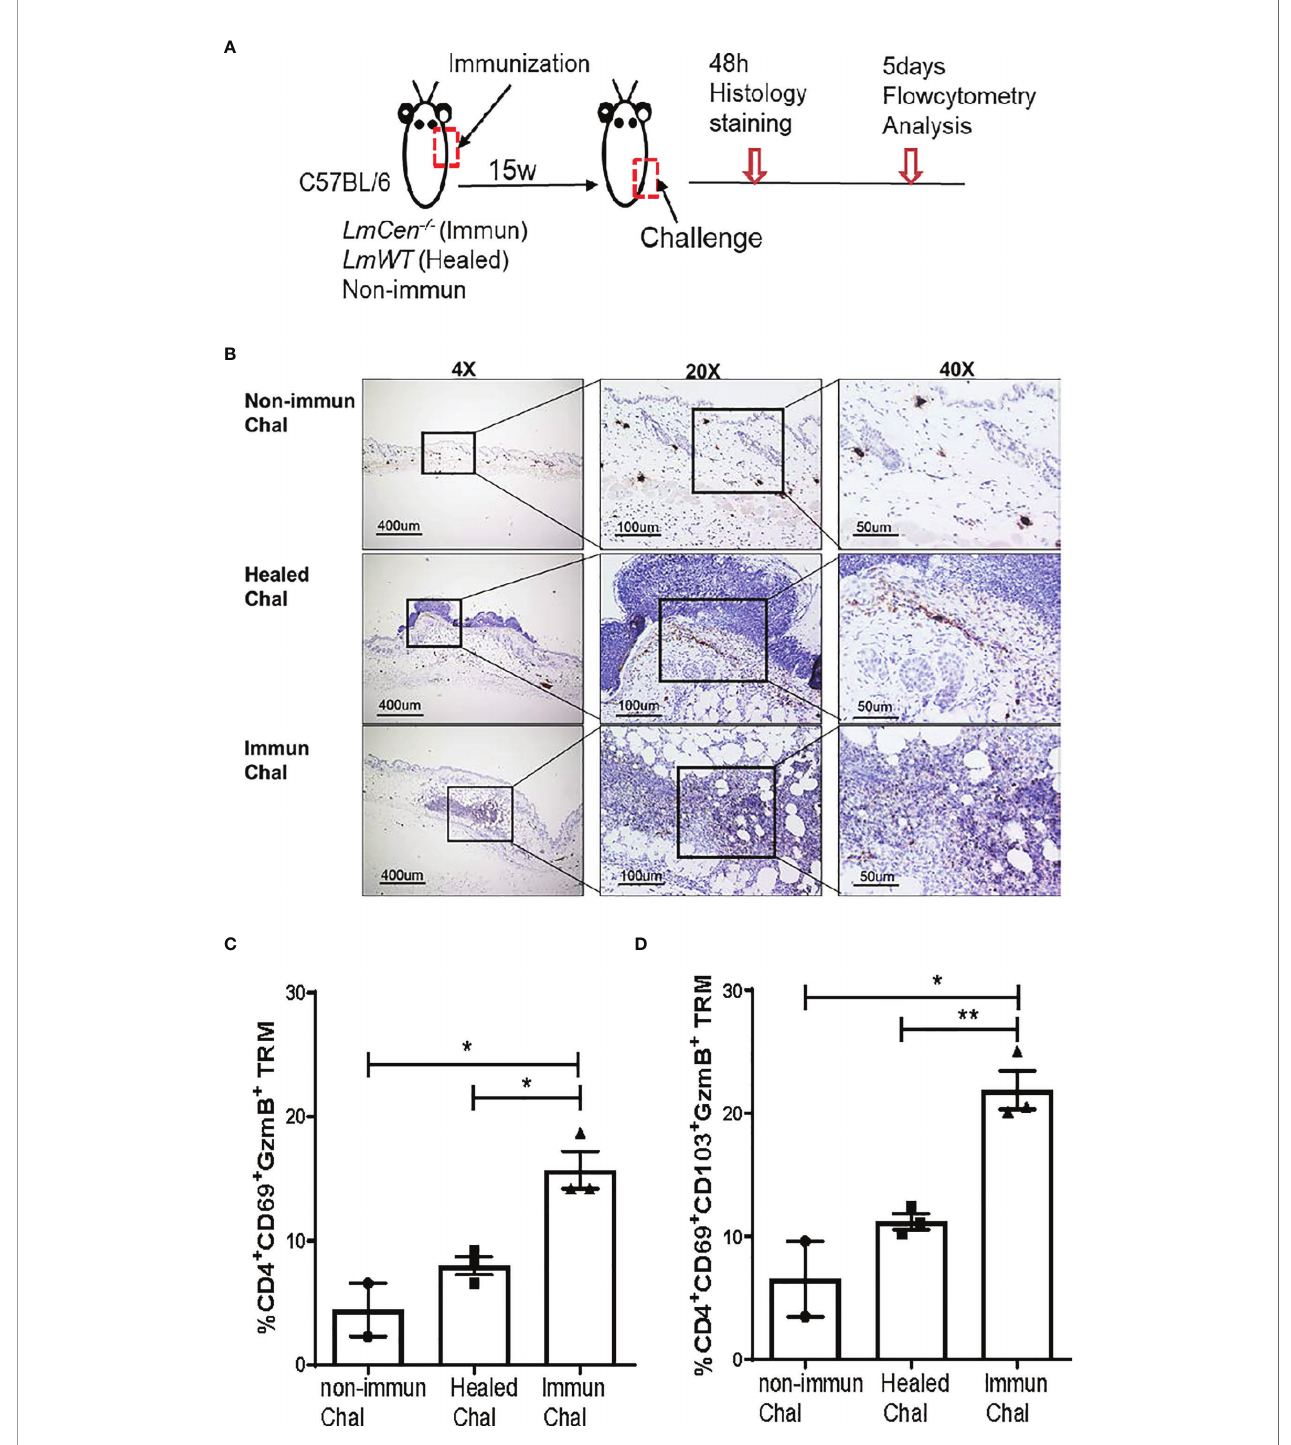
FIGURE 6 | TRM cells from LmCen -/ – immunized mice exhibit cytotoxic function by expressing granzyme B (GzmB). Fifteen-week 15w immunized and healed mice and non-immunized control mice were challenged in the fl ank skin with LmWT virulent parasites. (A) Schematic diagram of the site of injections. (B) Immunohistochemistry of the fl ank skin, at the challenge site, from 48 h challenged mice, stained with anti-granzyme B antibodies. (C, D) T cells from challenged skin were isolated 5 days post- challenge, and granzyme B production was assessed with fl ow cytometry analysis. (C) Portion of CD4 TRM cells, single positive (CD4 + CD69 + ), expressing granzyme B (D) Portion of CD4 TRM cells, double positive (CD4 + CD69 + CD103 + ), expressing granzyme B Results are representative of one of two independent experiments with total 2 – 4 mice per group. Bars represent the means with SEM in each group. Statistical analysis was performed by unpaired two-tailed t-test (** p < 0.004, * p < 0.03). h,